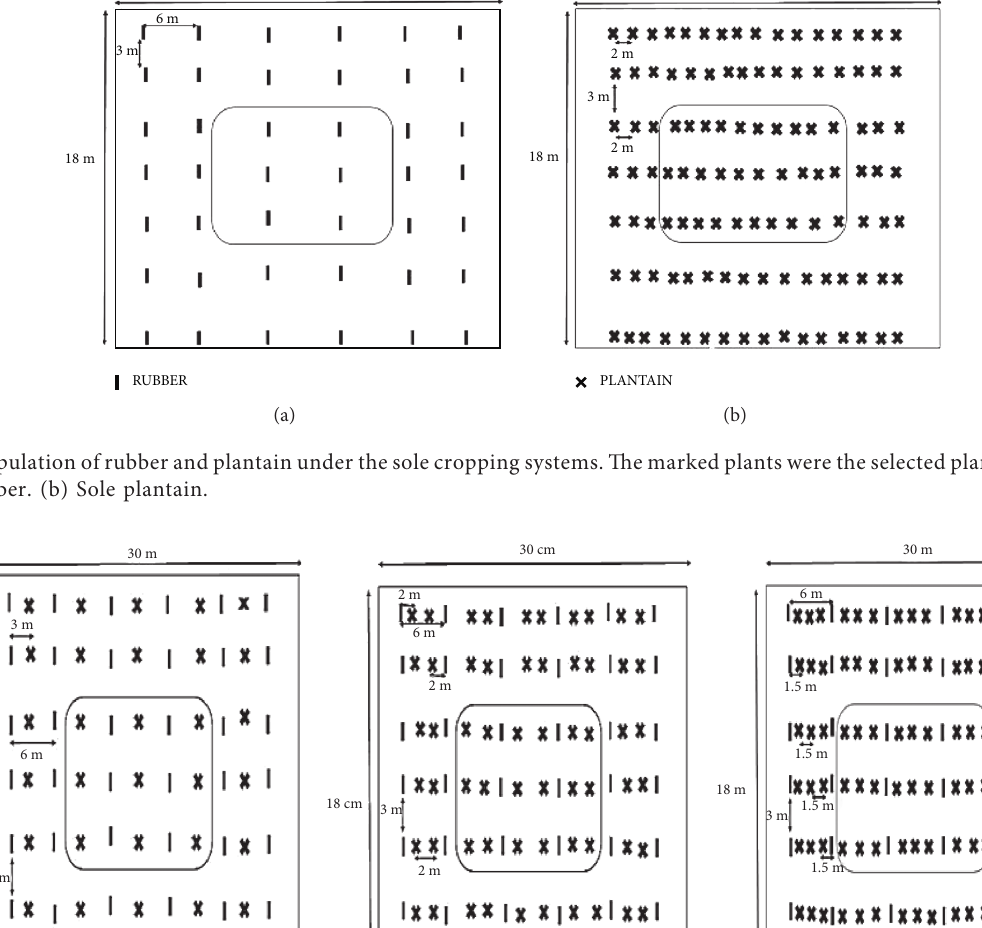
The value 0.8 is a correction factor. Leaf area index (LAI) is defined as the one-sided green leaf area per unit ground surface area in broadleaf canopies.